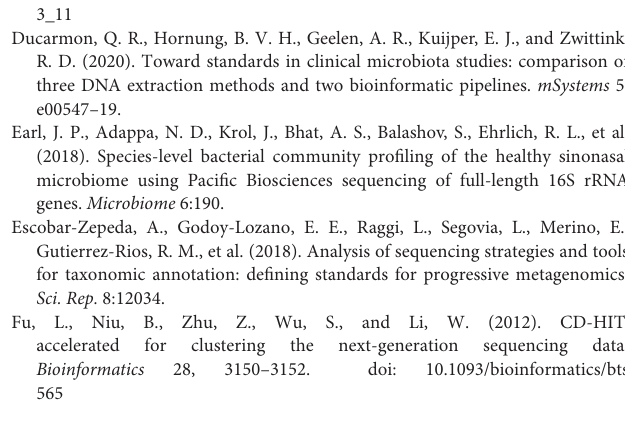
Supplementary Figure 1 | Comparison of taxon profiling of human fecal samples by 16S amplicon or WMS sequencing with different depths. Supplementary Figure 2 | The genus profile of 12 typical human stool samples assessed by 16S, S-WMS (1 Gb depth), and WMS (5 Gb depth). Supplementary Figure 3 | Genus composition of a low complexity artificial microbial community (MOCK1) assessed by S-WMS or 16S methods. Supplementary Figure 4 | The functional repertoire prediction of MOCK 2 at KEGG level 3 by S-WMS and 16S sequencing. Supplementary Table 1 | The species-level composition of MOCK1. Supplementary Table 2 | The species-level composition of MOCK2. Supplementary Table 3 | The genus profile of MOCK1 determined by 16S and S-WMS sequencing methods. Supplementary Table 4 | Genus quantification of MOCK2 by 16S and S-WMS